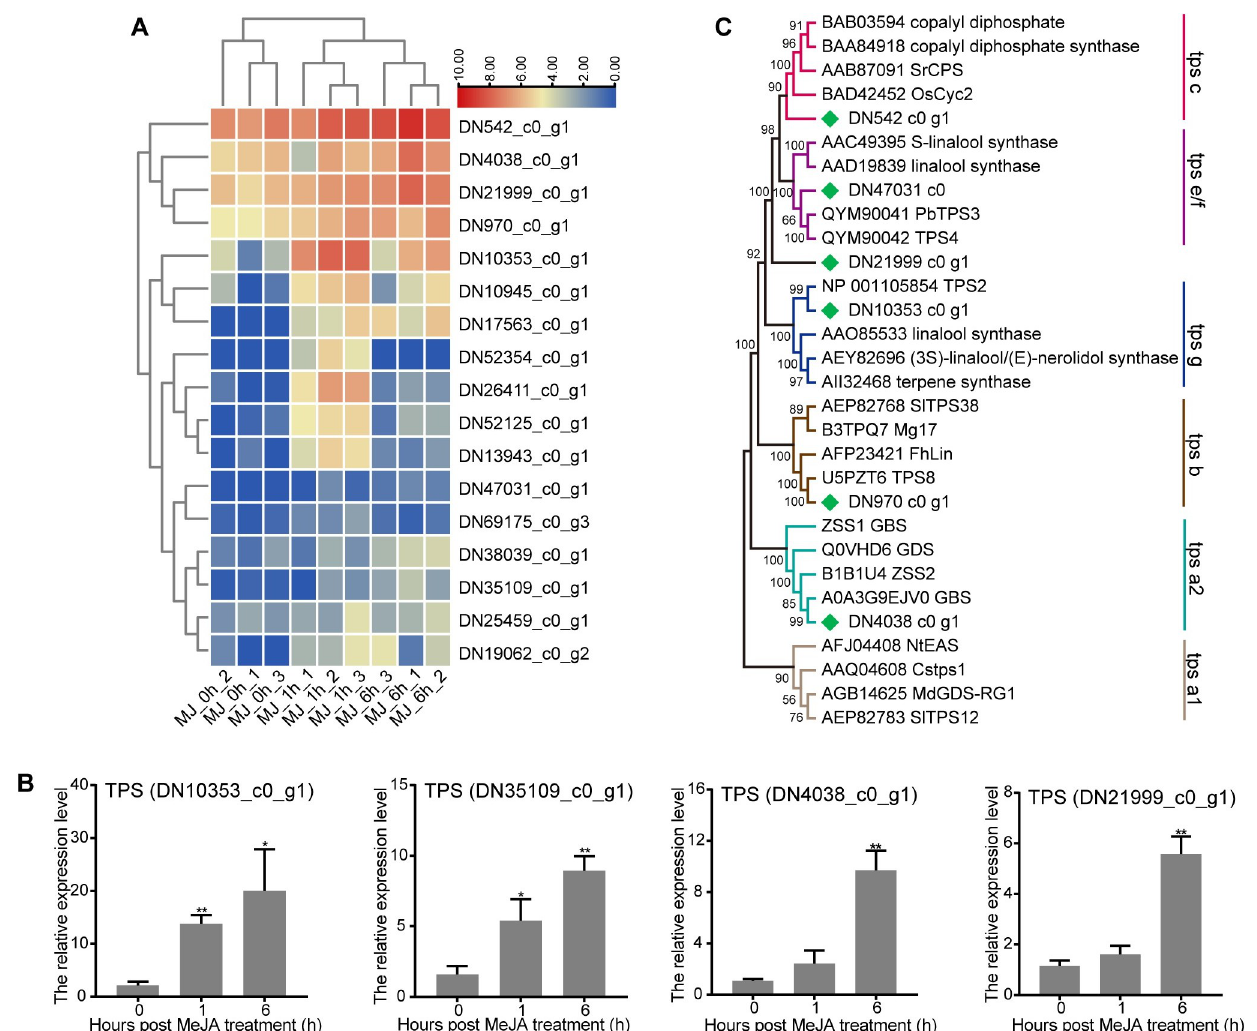
Fig 7. Analysis of CwTPSs induced by MeJA in C . wenyujin . (A) Transcriptional profiles of identified CwTPSs . The log2 (TPM) values for the DEGs were calculated based on three biological replicates for each time-point. The color scale from blue to red represents increase expression level. (B) Phylogenetic tree of CwTPSs with other TPSs from different plants. (C) Expression level of randomly selected CwTPSs determined by qRT-PCR. Three independent biological replicates were performed. Asterisks indicate significant difference ( � p < 0.05; �� p < 0.01).